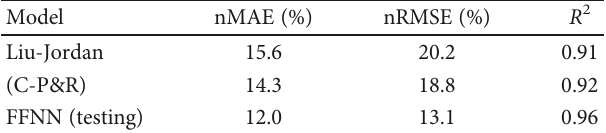
Table 2: Statistics for di ff erent methods of estimation of G